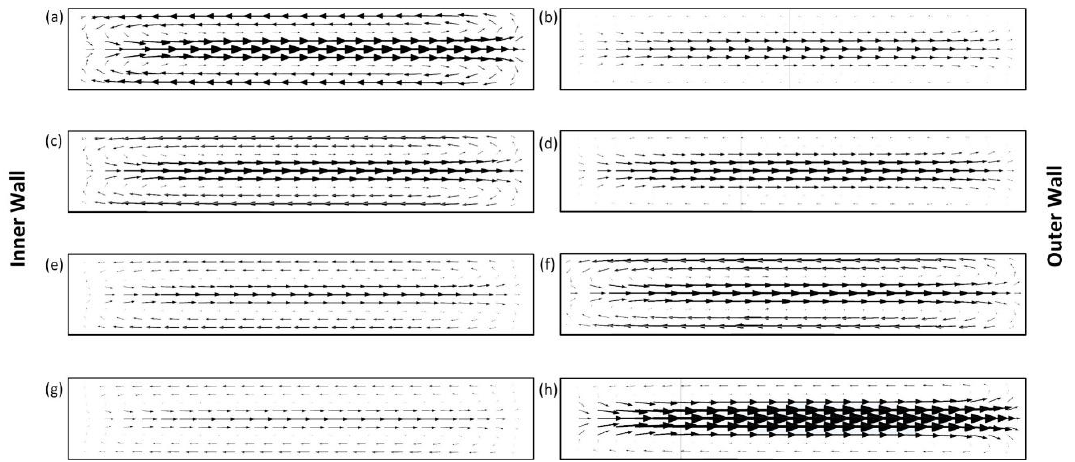
Figure 4. The variations of Dean velocity distribution at the beginning and at end of the last quarter loop of the channel for Case 1 ( a , b ), Case 2 ( c , d ), Case 3 ( e , f ), and Case 4 ( g , h ), respectively. The arrow lengths are proportional to the lateral velocity.